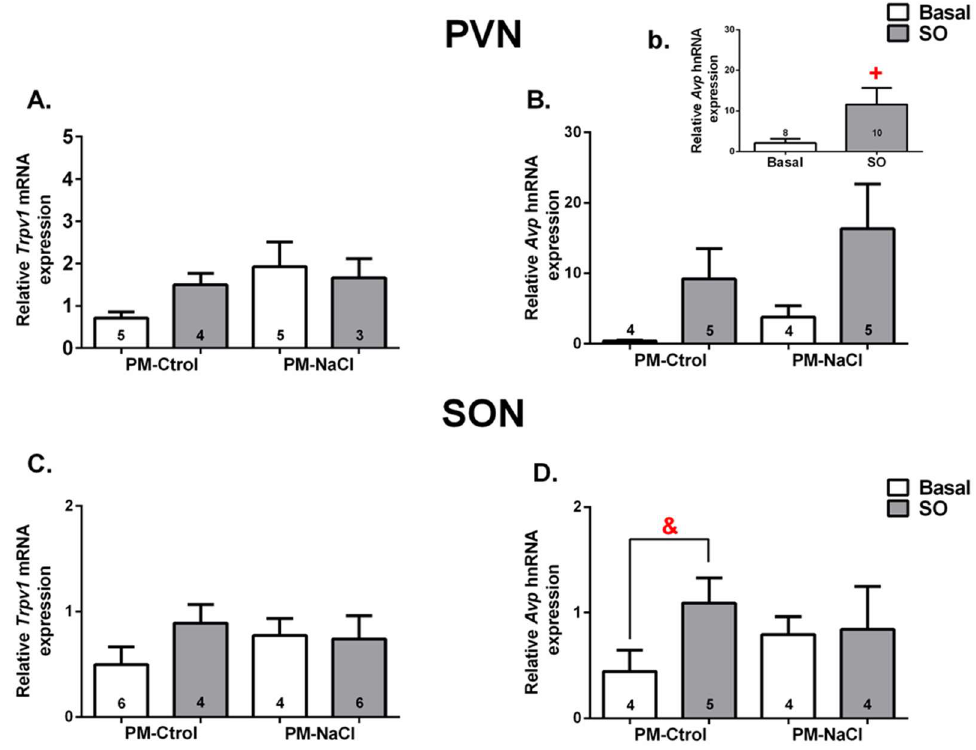
Figure 5. Sodium programming effects on brain expression of receptor potential vanilloid type 1 (Trpv1, mRNA) and heteronuclear vasopressin (Avp hnRNA) in response to sodium overload (SO). Relative levels of Trpv1 ( A , C ) and Avp hnRNA ( B , b , D ) in the paraventricular nucleus (PVN; ( A , B )) and supraoptic nucleus (SON; ( C , D )) of male PM-Ctrol and PM-NaCl animals under basal conditions (basal) and after SO. Values are mean ± SE. The numbers inside the bars represent the number of animals in the group. The numbers inside the bars represent the number of animals in the group. + significant difference at p < 0.05 between SO and basal groups. & significant difference at p < 0.05 between PM-Ctrol basal and PM-Ctrol SO groups.